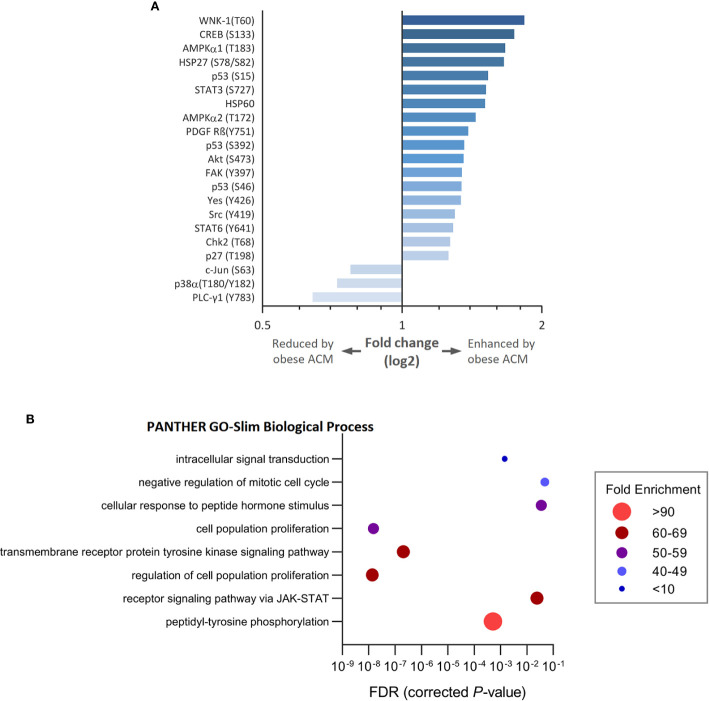
Modulation of kinase phosphorylation profiles and associated biological processes in estrogen receptor positive T47D breast cancer cells in response to adipocyte secretome from obese- compared with normal conditions. (A) Graph shows fold changes of phosphorylation pattern in T47D cells following exposure to adipocyte conditioned media (ACM) from obese relative to normal conditions. Phosphorylation patterns modulated ≥ 1.25-fold are shown. (B) Bubble plot shows the fold enrichment of biological processes over-represented among enhanced phosphorylated kinases. False discovery rate (FDR) < 5%.